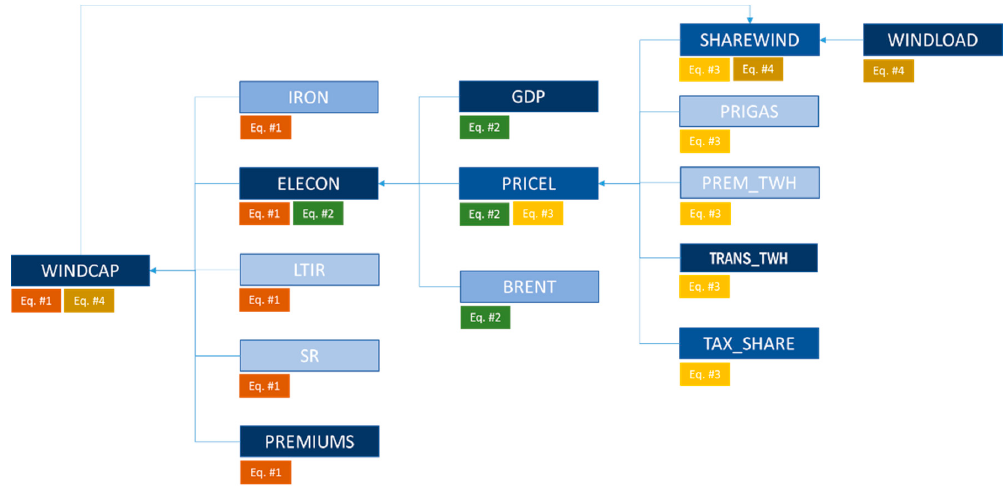
Figure 2. Illustrating the model specification. Source: own elaboration.